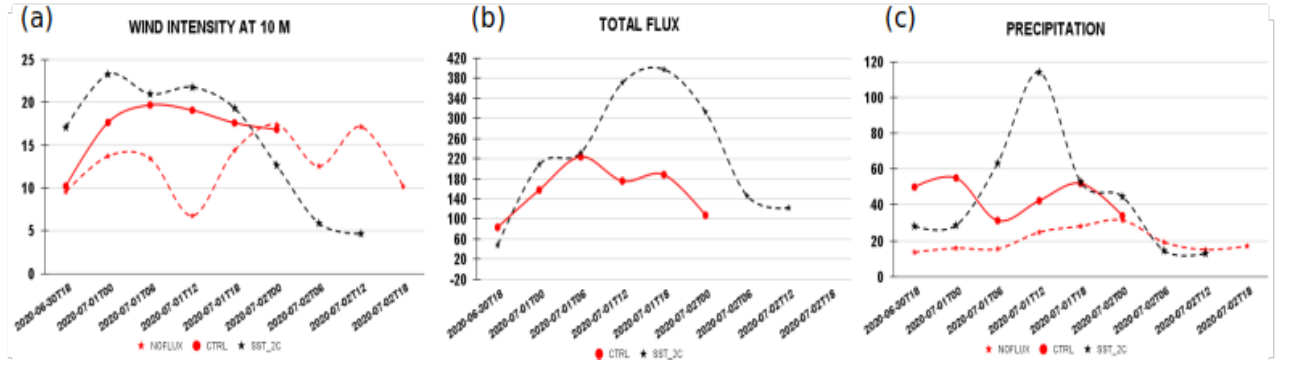
Figure 9. Accumulated precipitation (mm) every 6 h following the cyclone center (box of 10° × 10°) and track for ( a ) ERA_BMJ, ( b ) ERA_BMJ_NO, and in ( c ) SST_2C experiments.